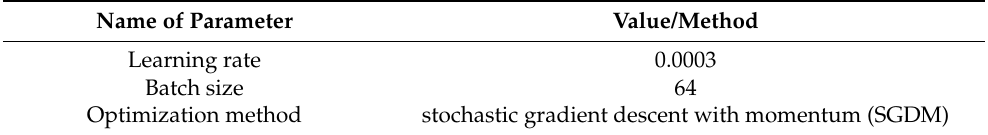
Table 2. Learning parameters set during the training